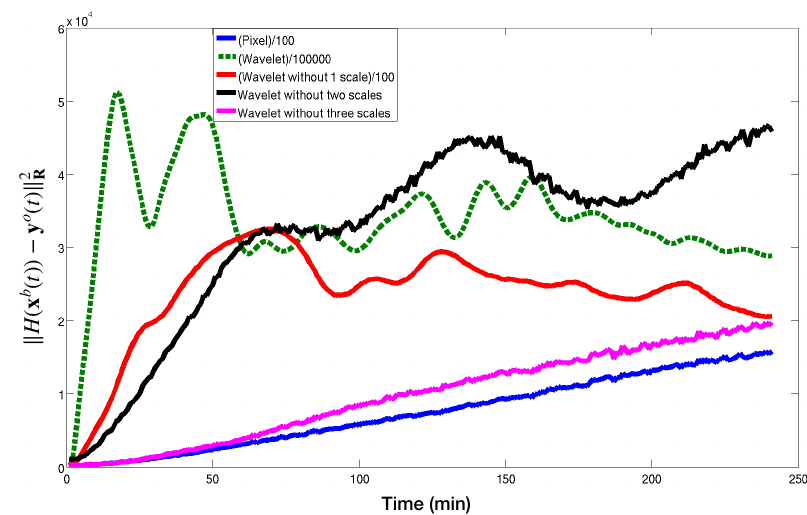
Figure 10. Discrepancy between the background ( no assimilation ) concentration trajectory and the successive observations along time. The discrepancy measurement is computed using the norms given by the observation term of the cost function for various methods: pixel ( solid blue ), classical wavelet ( dashed green ), wavelet excluding the finest scale ( solid red ), wavelet excluding the two finest scales ( solid black ), wavelet excluding the three finest scales ( solid pink ).